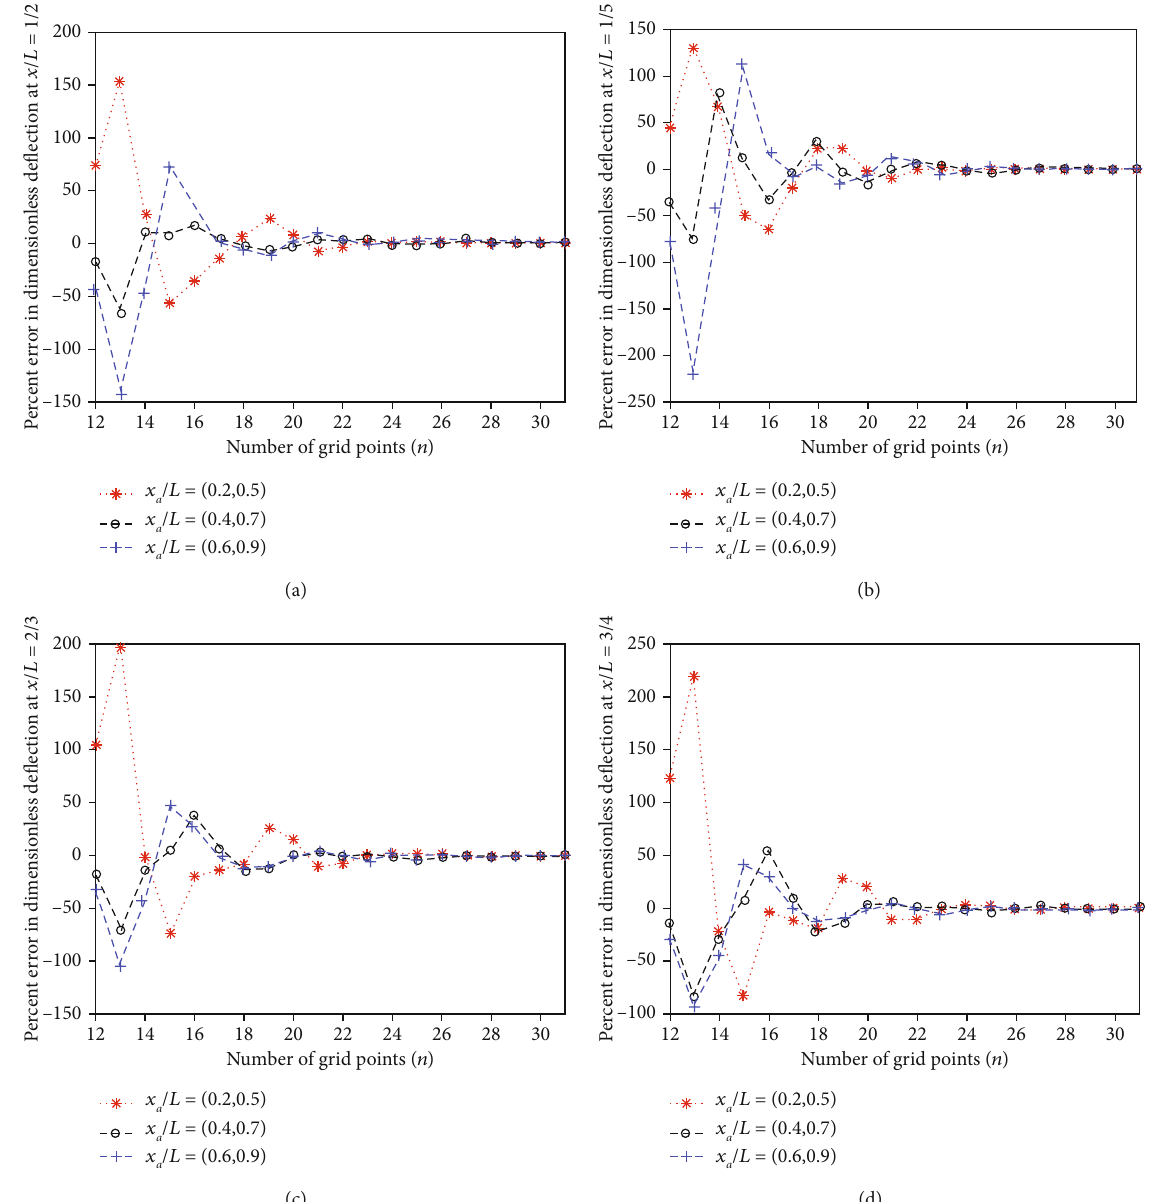
Figure 3: Convergence and accuracy of the dimensionless de fl ection of a simply supported beam under a constant voltage V actuator at di ff erent locations for ( α = 0 : 08 ) at x / L = 1/2 (a), x / L = 1/5 (b), x / L = 2/3 (c), and x / L = 3/4